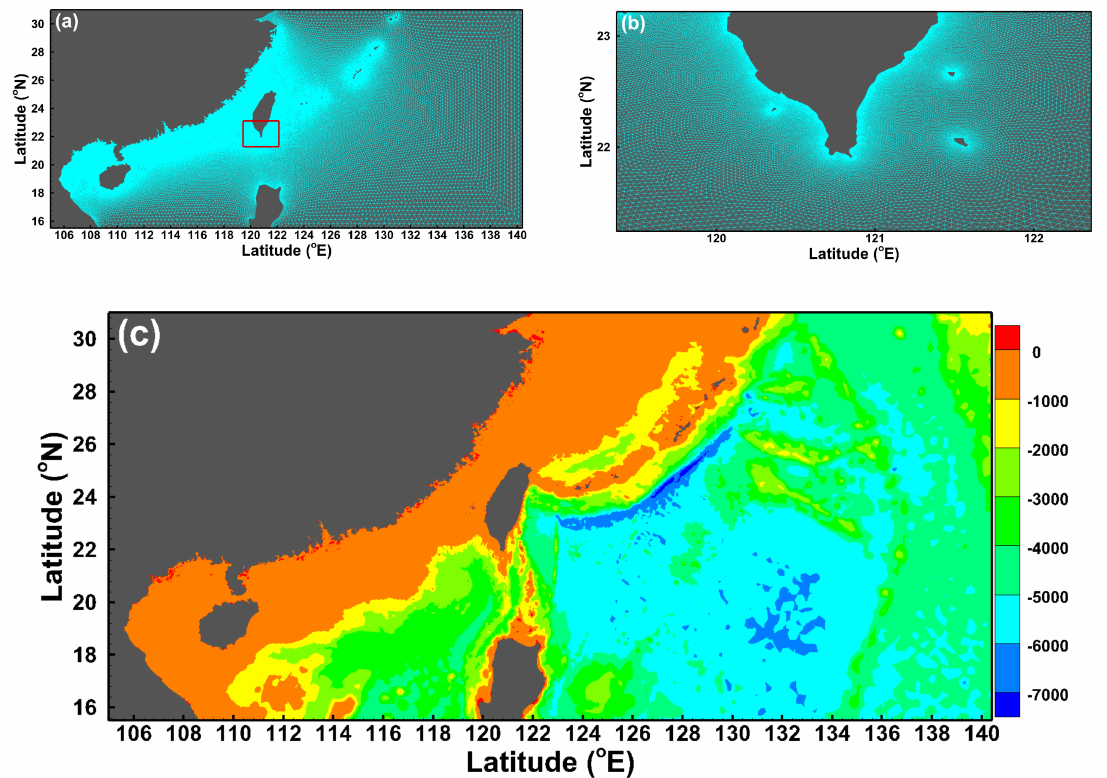
Figure 3. Entire computational meshes ( a ), enlargement of high-resolution unstructured grids for the southern coastal waters of Taiwan ( b ), and bathymetry ( c